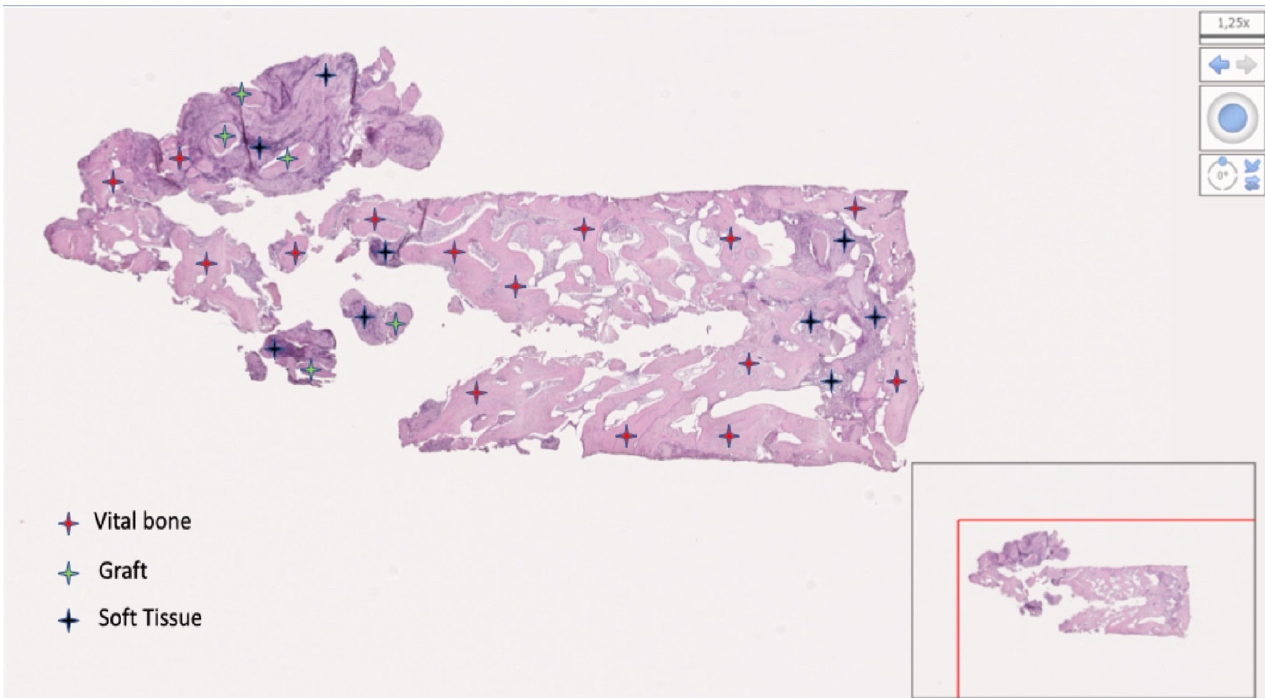
Figure 12. Bone sample taken at the upper right first premolar. The patient (number 13) received decellularized bovine compact bone from bovine femur alone. The bone was 46.19%; soft tissue was 34.61%; residual graft was 19.20%.